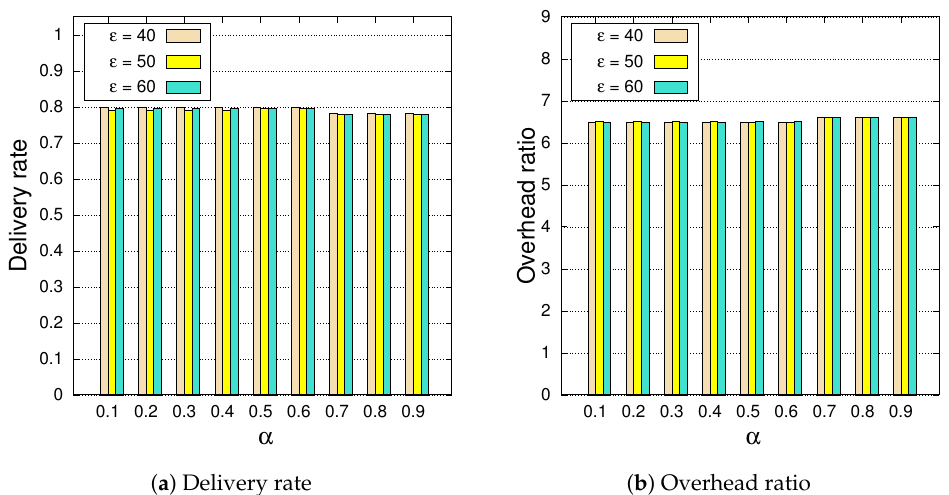
Figure 6. Results by MPMF with different values of α and (cid:101) under NCCU trace (TTL = 5 h and buffer size = 10 MB).